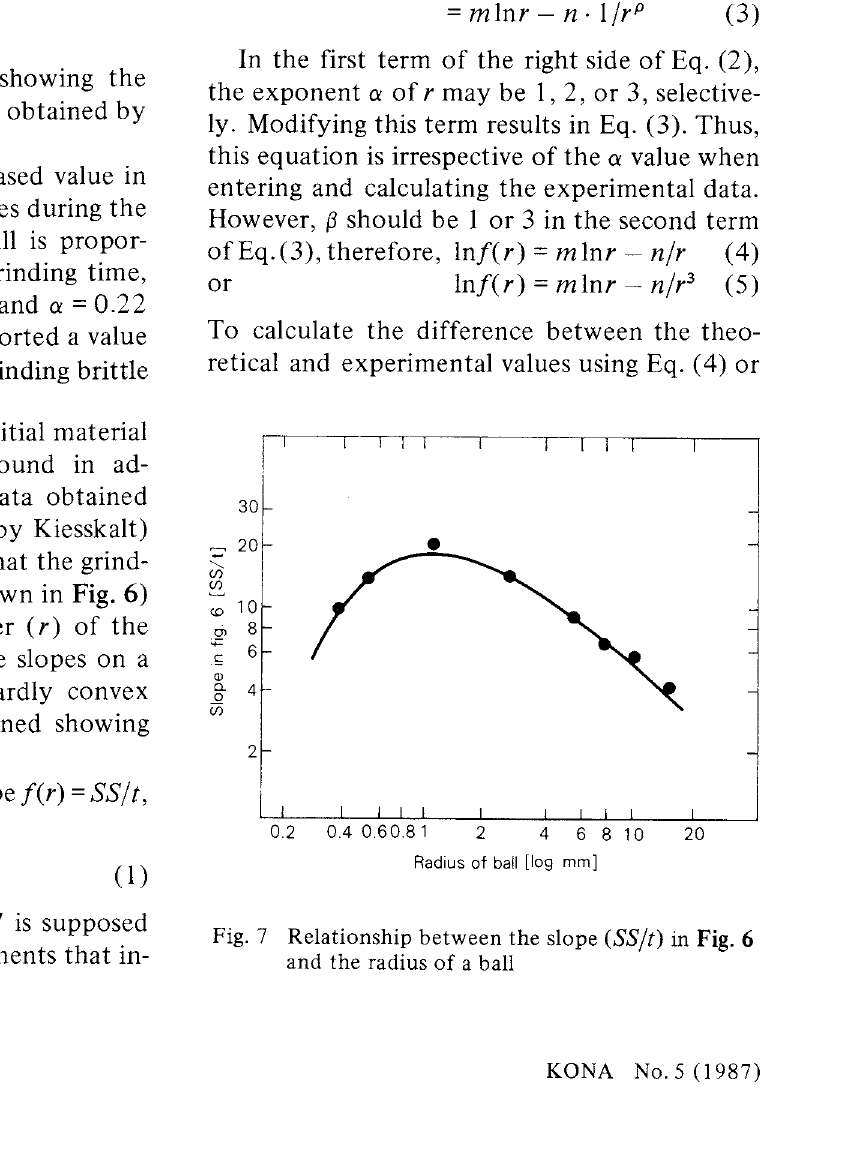
Fig. 6 Relationship between specific surface area and grinding time